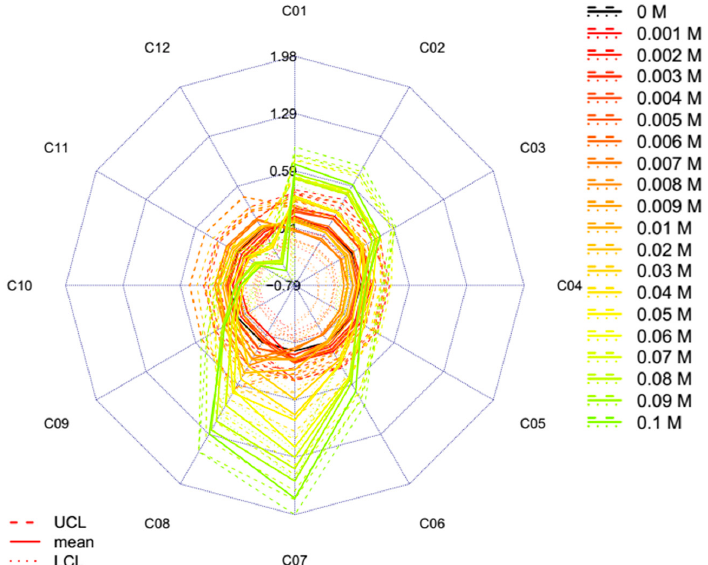
Figure 6. Aquagrams with 95% confidence intervals of Milli-Q water ( n = 150) and 0.001–0.1 M KCl solutions ( n = 120) calculated with the temperature based aquagram calculation method on the individual concentrations (UCL—upper confidence level, LCL—lower confidence